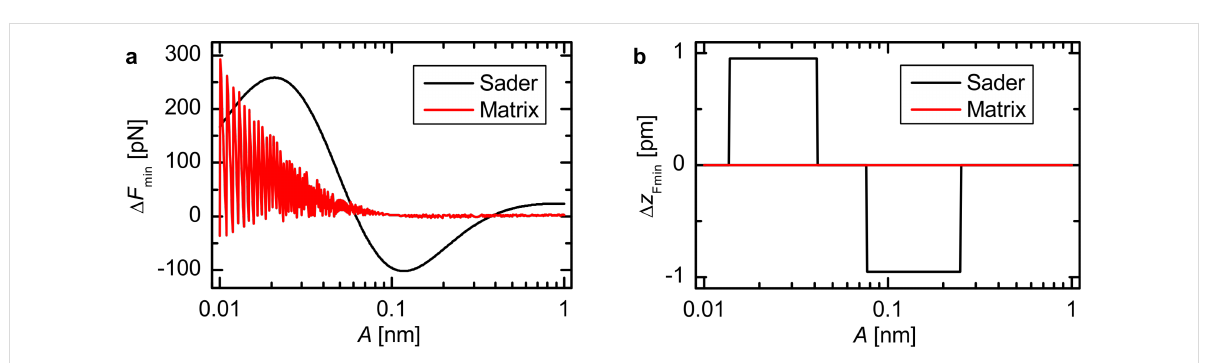
Figure 7: Amplitude dependence of the deviation in magnitude (a) and position (b) from the force minimum for the Lennard-Jones force law. The steps in (b) are due to the discretization of the z -values.